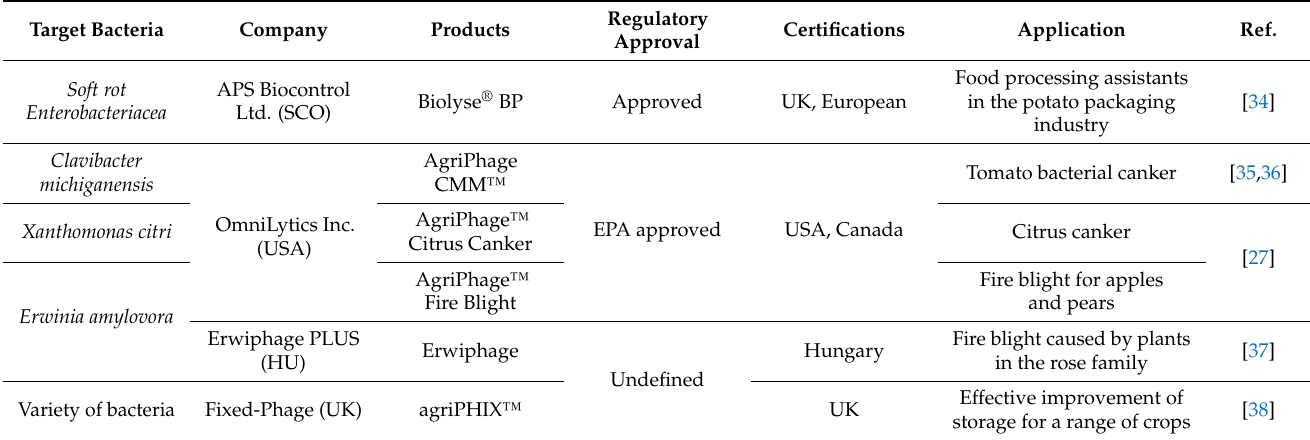
Table 1. Commercial phage products for plant